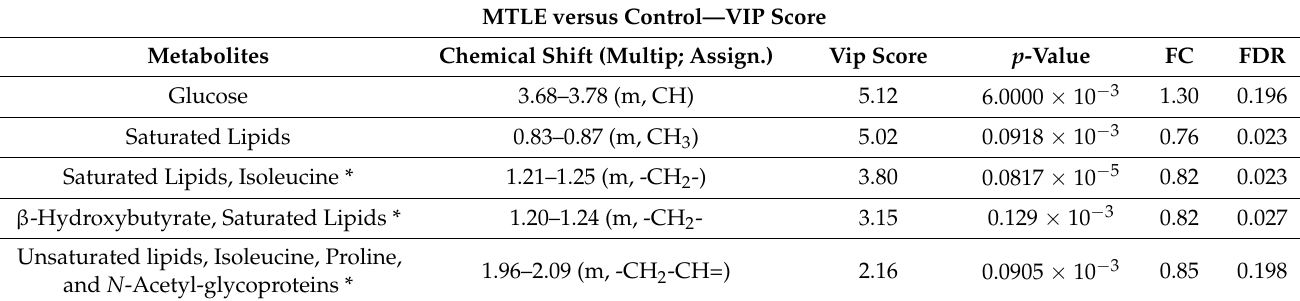
Table 2. Table showing the metabolites identified in different concentrations and their respective chemical shifts elucidated by the highest VIP values (VIP score). The p -values, calculated from the t-test, FC (fold change), and false discovery rate (FDR) are also shown.